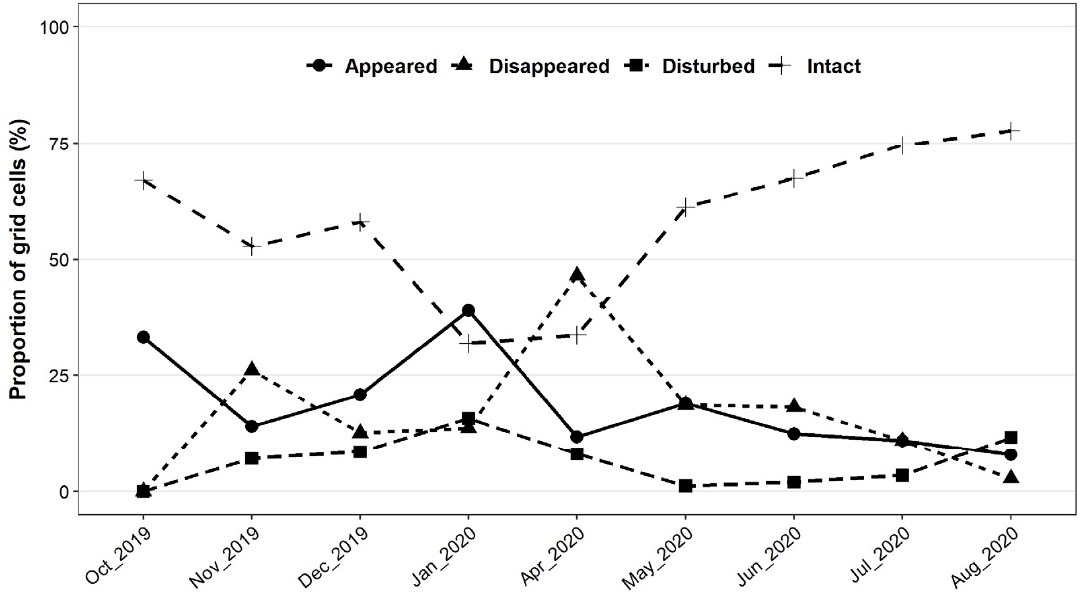
Figure 2. Temporal variation in boar rooting activity in the study area, measured by the proportion of map grid cells, in each category of rooting occurrence by wild boar.